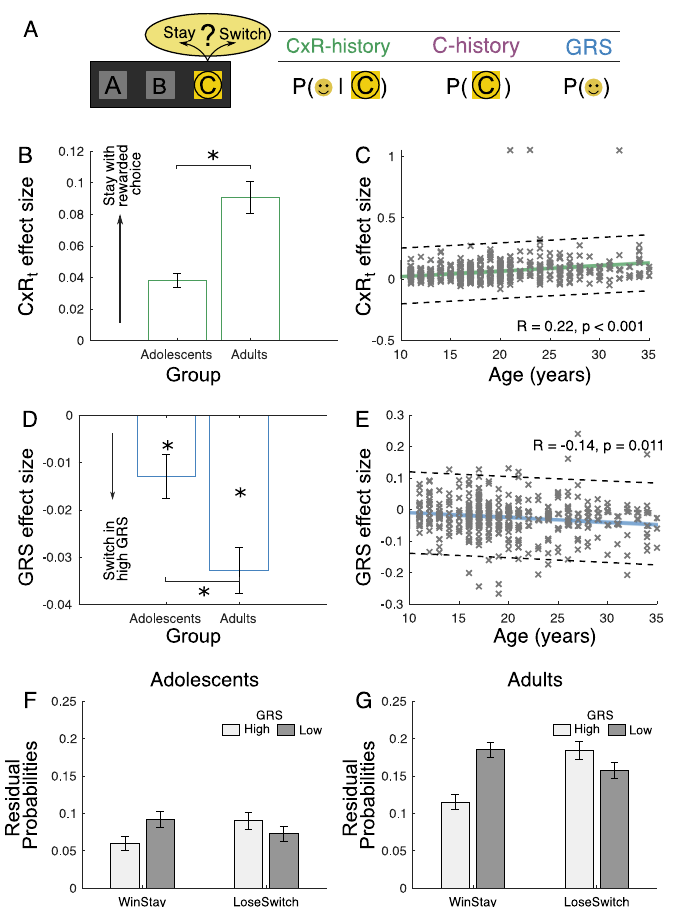
Fig 3. Local reward learning and GRS-based learning became more pronounced over the course of adolescence. (A) In our “credit assignment GLM,” we reframed the 3-choice decision problem as a foraging-style decision between staying and switching away from a currently pursued choice C. For every trial, we considered the chosen option C and analysed whether participants would stay with C on the next trial. We analysed this decision as a function of three sets of regressors: previous local (i.e., contingent) rewards for C (CxR-history), the pure choice history (C-history), and the global reward state (GRS). The right-hand illustration indicates the quantities that encapsulate these three effects: the reward outcome (schematized by a smiley face) contingent on a choice (i.e., the probability of reward given C), the repetition of a choice per se (i.e., the probability of choosing C independent of reward), and the overall recent reward probability irrespective of choice (i.e., the probability of reward independent of C). Panels B, C, D, and E show effect sizes for component parts of this GLM. (B) Considering the effect of the most recent outcome on the tendency to repeat a choice (CxR t ), we found that young adults had a significantly stronger tendency to repeat rewarded choices compared to adolescents. (C) The effect size linearly increased with age. (D) Independent and in addition to local reward learning, the GRS had a negative effect on staying with an option: Participants tended to stick more with a choice if it was encountered in the context of a low overall GRS. Such negative GRS effects were found in both adolescents and young adults with a significant difference between them. This indicates that young adults, even more than adolescents, had the tendency to contextualise rewards by the GRS. (E) This was replicated by a linear decrease of GRS over time. (F) Plot shows residual probability of staying after a win and switching after a loss (i.e., a no-reward) separated by low and high GRS (median split) for adolescents. (G) The same is shown for young adults. Note that in this visualisation, the GRS main effect from panels B and E is expressed as an interaction with WinStay/LoseSwitch strategy in panels F and G. The interaction effect increased for older participants: Participants were even more likely to repeat rewarded choices when encountered in a low GRS (darker bars) and, simultaneously, more likely to switch away from losing choices if encountered in a high GRS (lighter bars). (“x”s indicate individual participants; plots show mean − /+ SEM; solid lines in the right plots indicate the linear trend. Dashed lines represent 95 th % confidence intervals. � p < 0.05). Data for B-G are available in S1 Data (Figure3